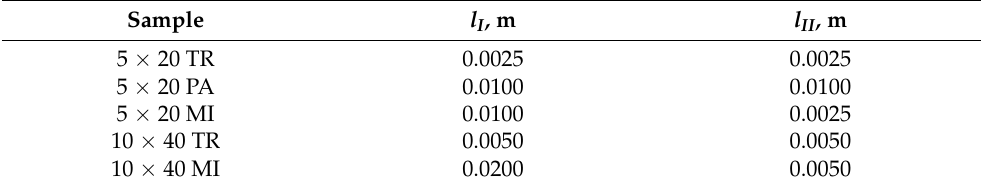
Table 3. The values of l I and l II dimensions adopted for individual samples.